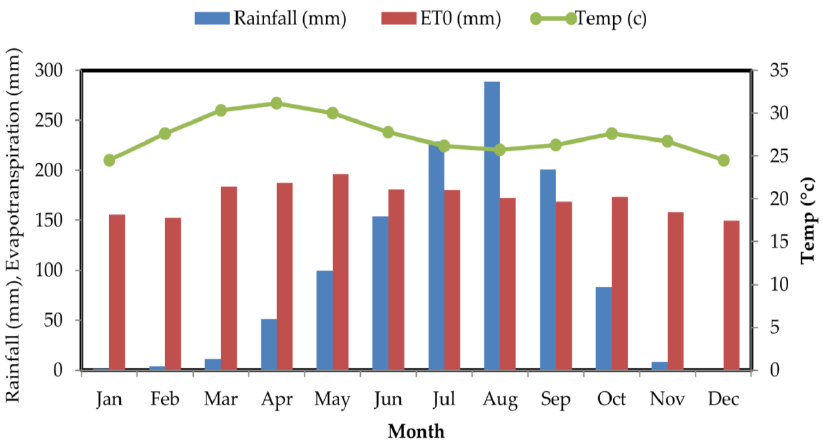
Figure 2. Monthly average rainfall (mm) (blue bars), potential evapotranspiration ET0 (mm) (red bars) and temperature (green line) in the Klela Basin from 1970–2013 (data Source from DNM [17]).